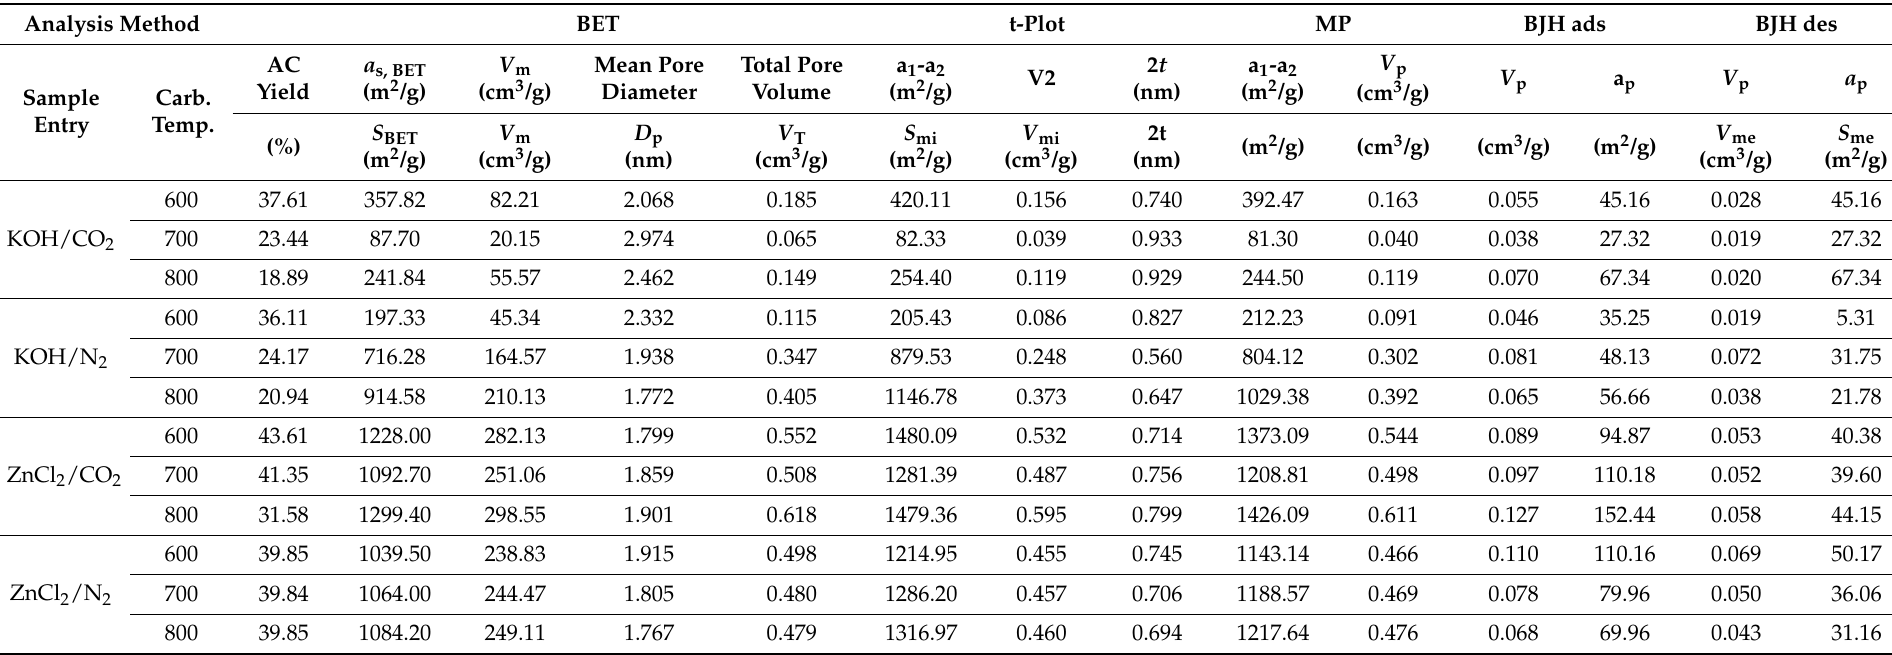
Table 1. Surface area analysis using different models of activated carbons prepared under different